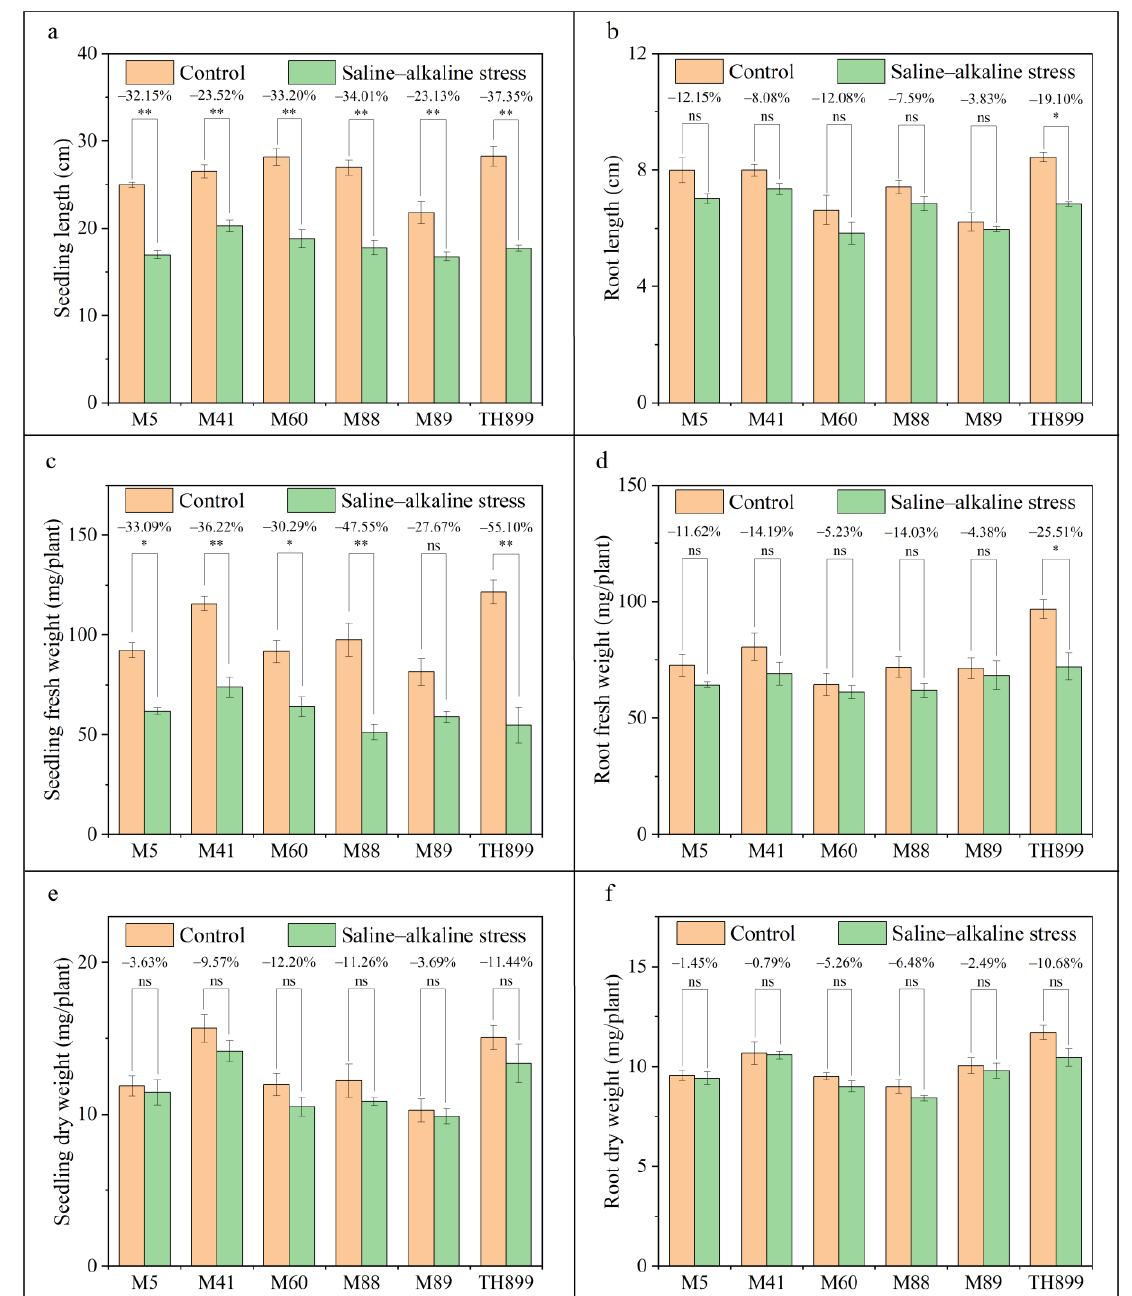
Figure 3. Seedling growth and biomass of mutant lines and the parent TH899 under control and saline–alkaline stress conditions. ( a ) Seedling length, ( b ) root length, ( c ) seedling fresh weight, ( d ) root fresh weight, ( e ) seedling dry weight, and ( f ) root dry weight. Bars are the means and standard errors of four replications. ** indicates significant differences at p < 0.01; * indicates significant differences at p < 0.05; and ns indicates no significant differences. The values on top of the bars indicate the decrease in each agronomic trait under saline–alkaline stress relative to the